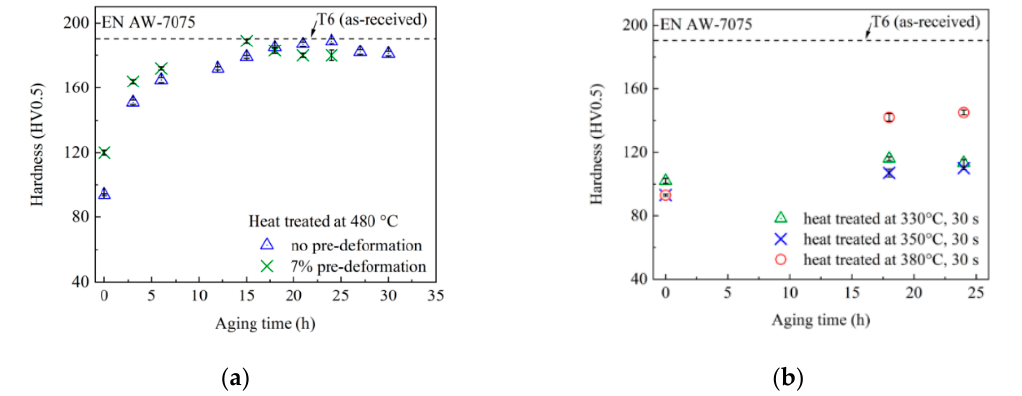
Figure 8. Hardness as a function of artificial aging time for EN AW-7075, subjected to different heat treatment procedures using a holding time of 30 s. ( a ) SHT without and with subsequent deformation, ( b ) retrogression without subsequent deformation.